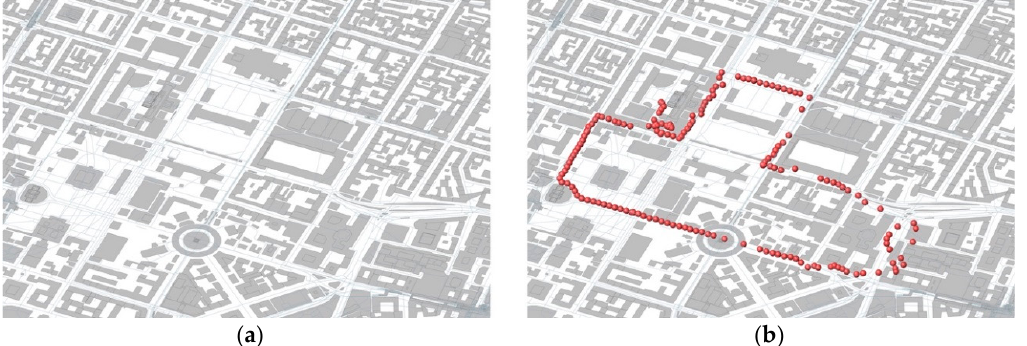
Figure 24. ( a ) Figure ground map; ( b ) GPS signals over the path.